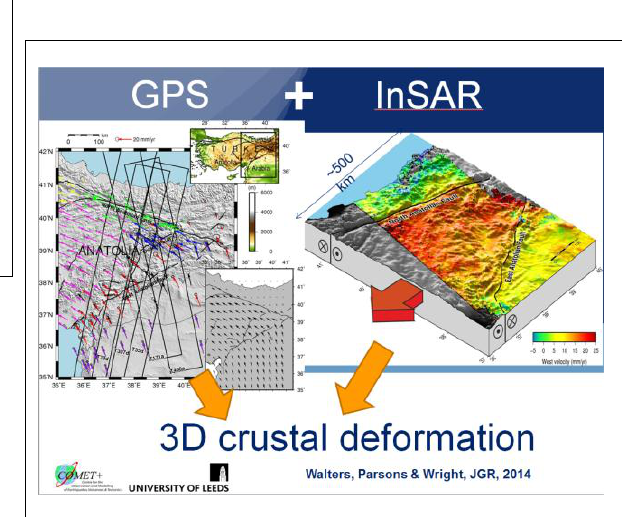
Figure 4. 3D crustal deformation in the regions of the North and East Anatolian faults, courtesy of COMET+. The combination of in-situ GPS measurements